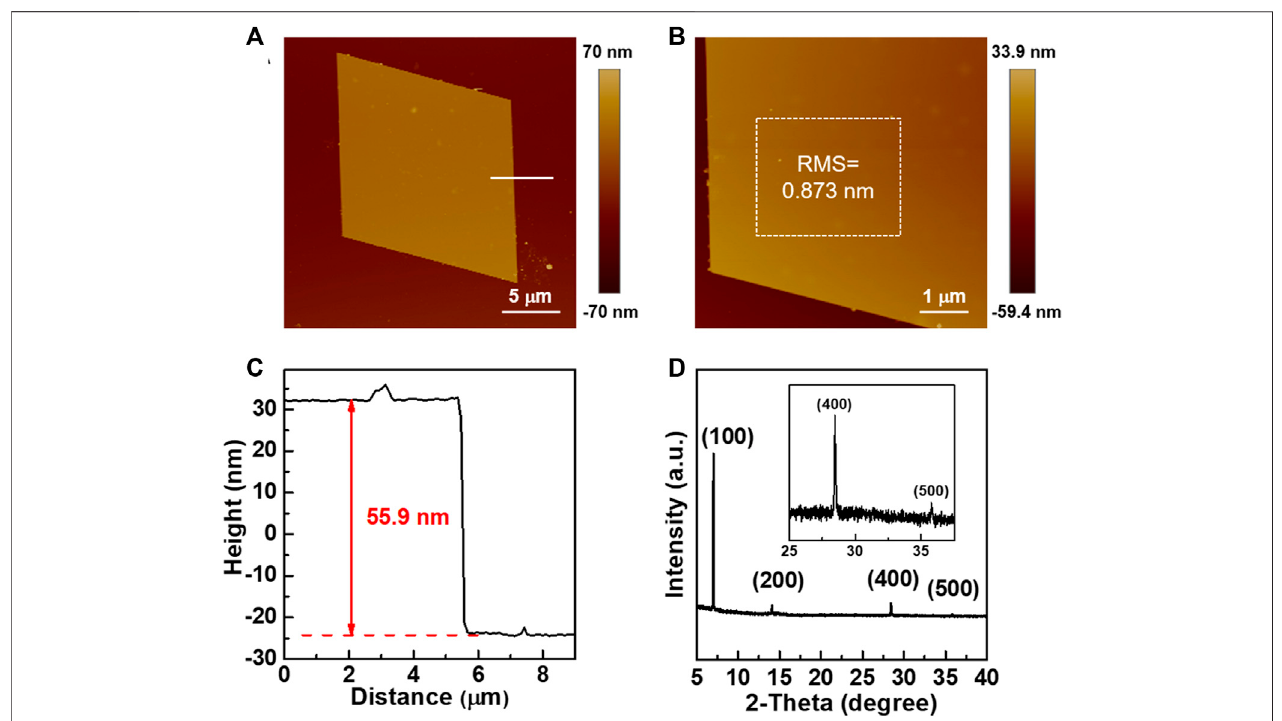
FIGURE 3 | (A, B) AFM images of TTN2 microcrystals (C) Height pro fi le of a TTN2 microcrystal (D) XRD spectra of TTN2